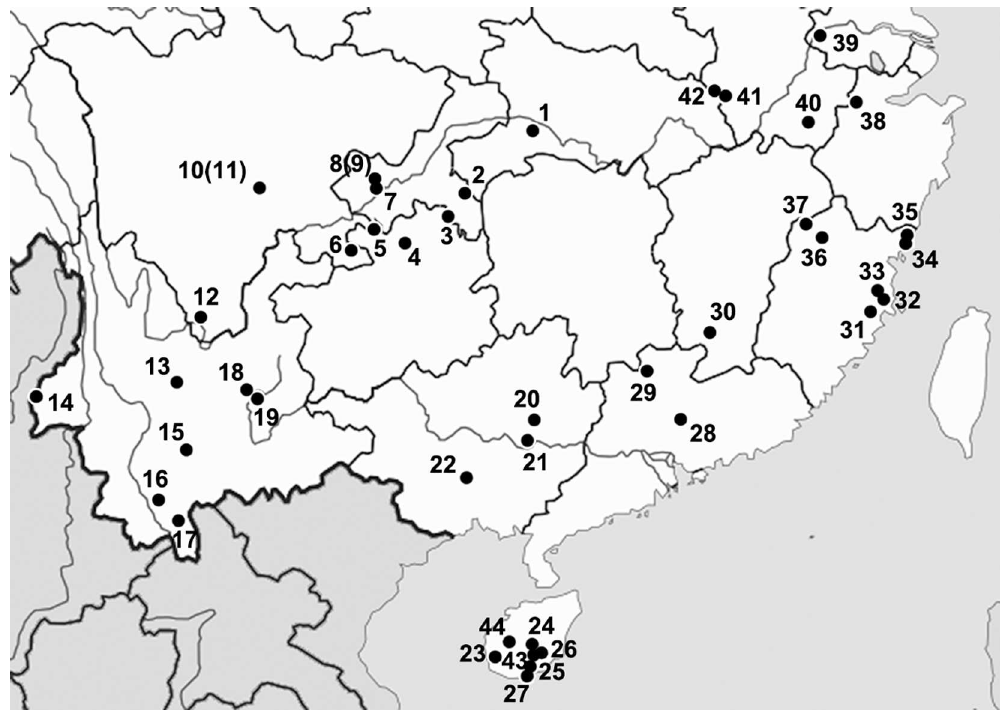
Fig 1. Distribution and collection localities of analyzed specimens of Ectobiidae in China. Numbers for samplinglocalitiesare as indicatedin Table 1. Reprintedfrom [57] under a CC BY license, with permissionfrom [Chao LI]